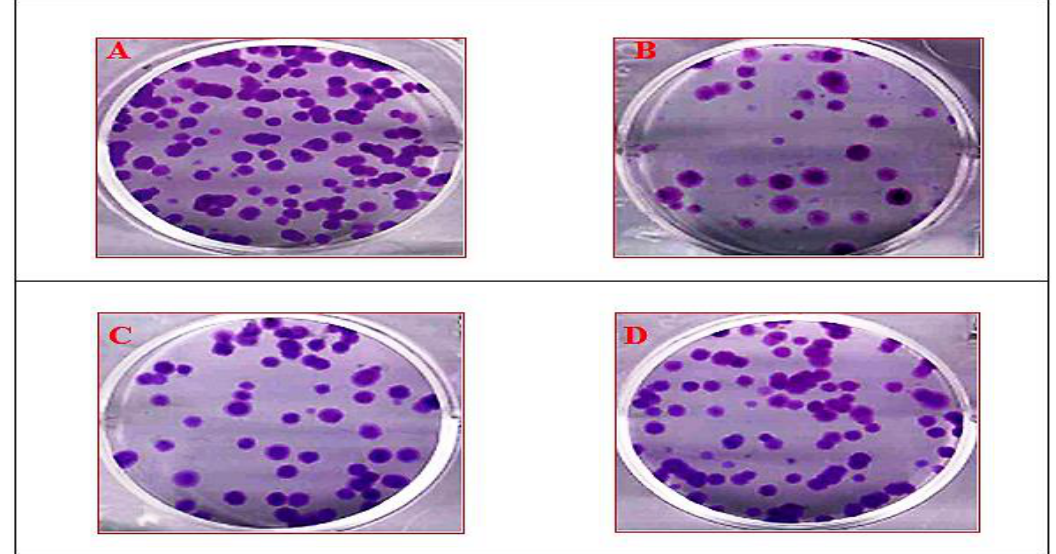
Figure 7. Clonogenic assay of PC 12 cell lines during treatment with ketamine, clozapine, and plant compound. ( A ) PC 12 cell lines after seeding 100 cells/plate. ( B ) PC 12 cell lines treated with ketamine after seeding 100 cells/plate. ( C ) PC 12 cell lines treated with clozapine for 2 h after treatment with ketamine after seeding 100 cells/plate. ( D ) PC 12 cell lines treated with compound for 2 h before ketamine treatment after seeding 100 cells/plate. Scale: 100 µ m.